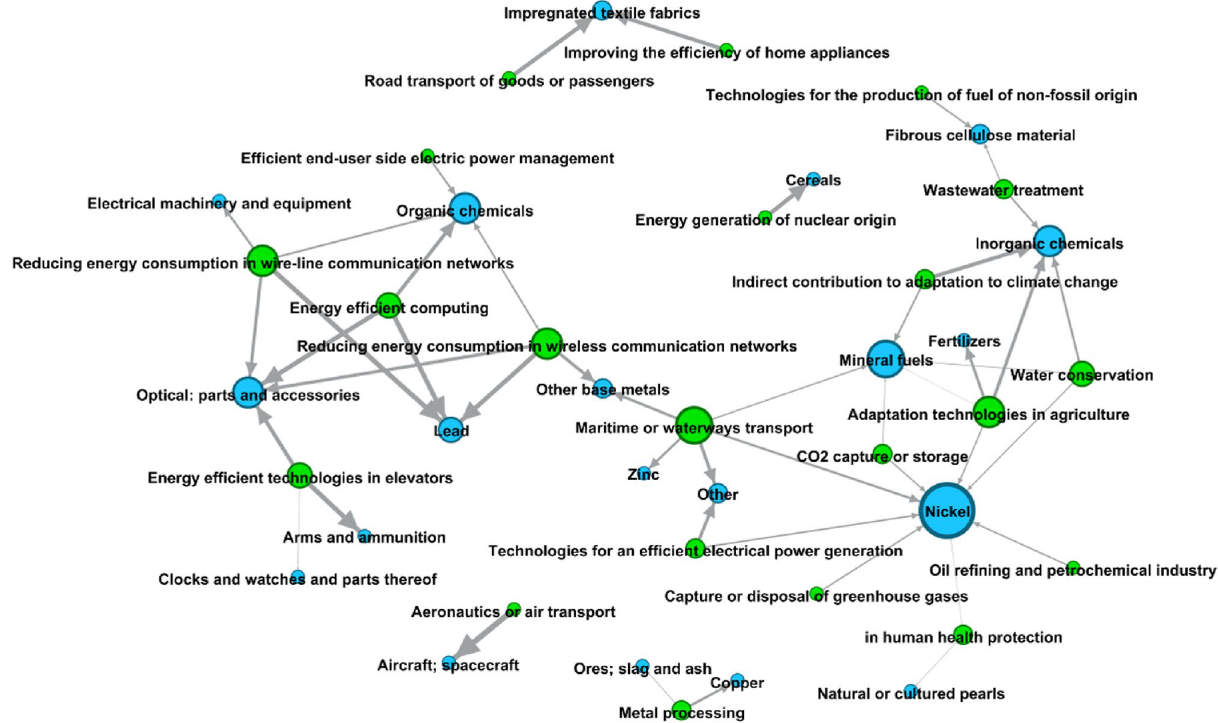
Figure 2. Directed network from green technologies to exported products for time lag (cid:31) T = 0 and 2-digit product aggregation level. Nodes’ size depends on their degree; edges are weighted according to the value of the Assist matrix A τπ